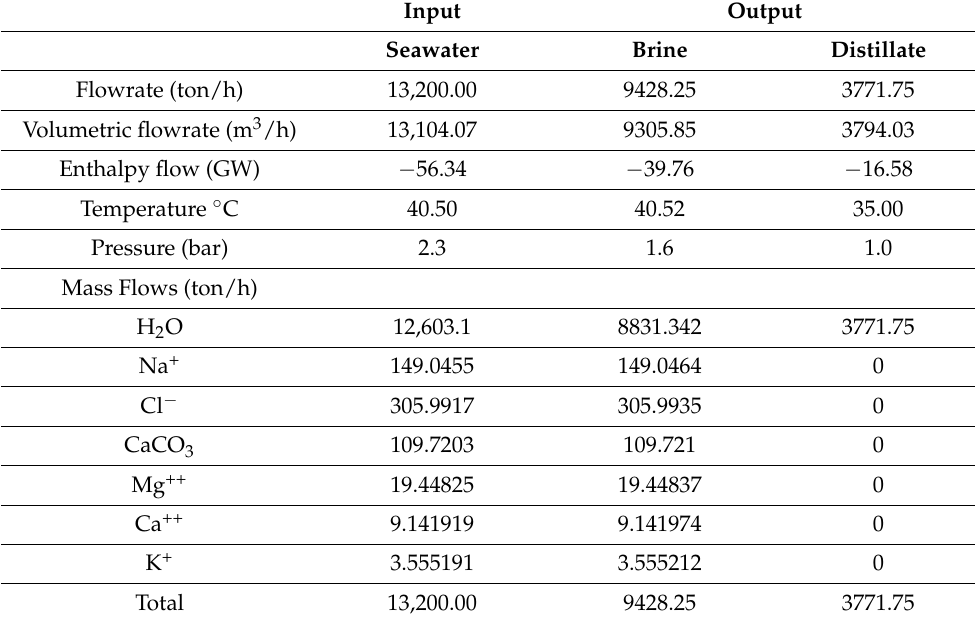
Table 3. Overall mass and energy balances of the existing MED-TVC desalination plant.